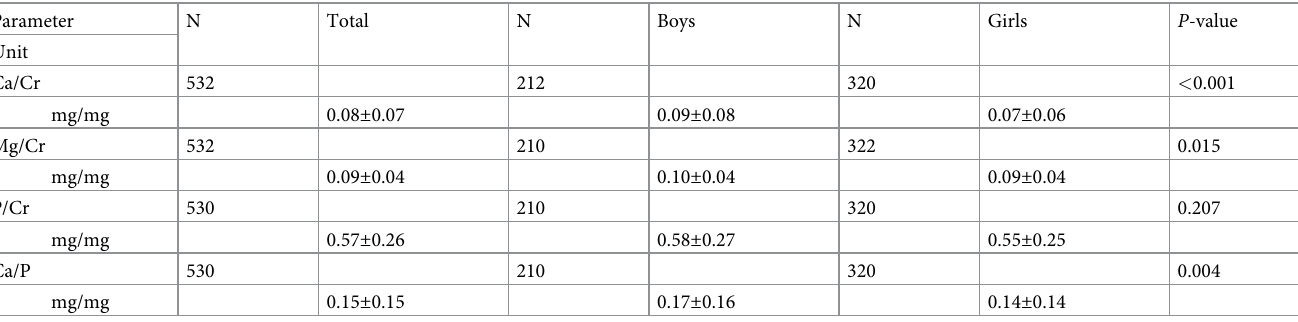
Table 2. Urinary Ca/Cr, Mg/Cr, P/Cr, and Ca/P ratios of elementary Emirati schoolchildren.